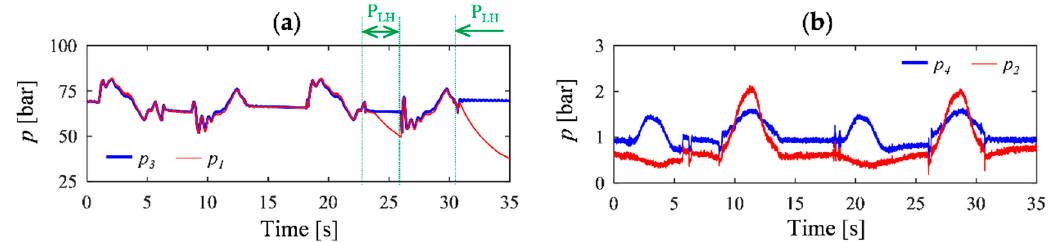
Figure 11. ( a ) Measured pressures in the bore-side of the system; and ( b ) measured pressures in the rod-side of the system.